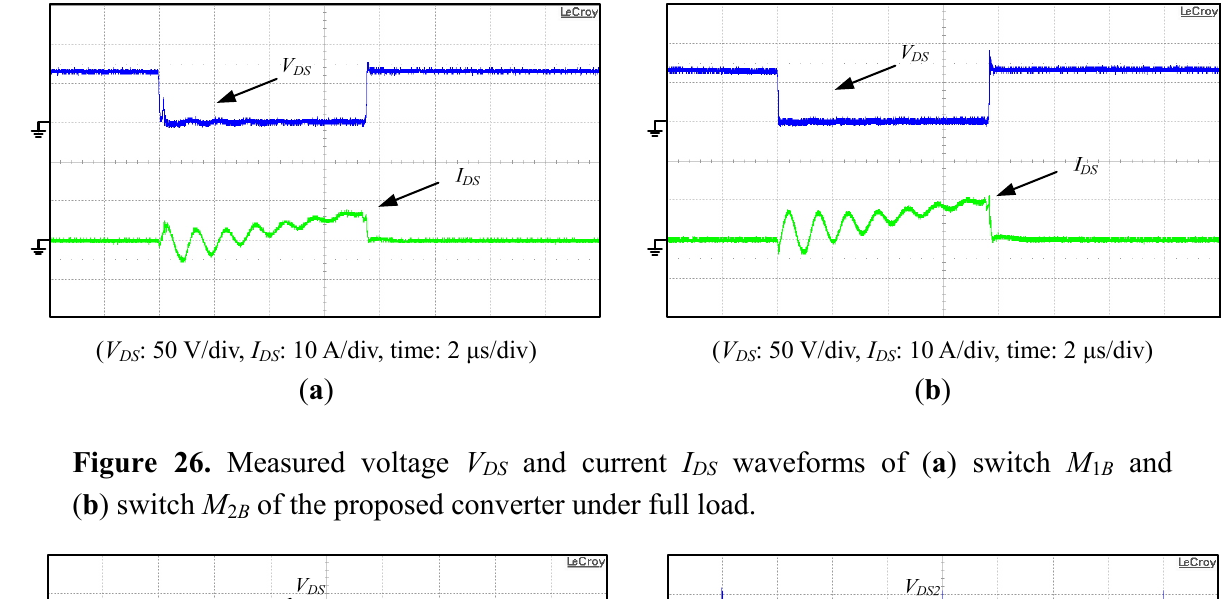
Figure 25. Measured voltage V ( b ) switch M of the proposed converter 10% of full load. 2 B